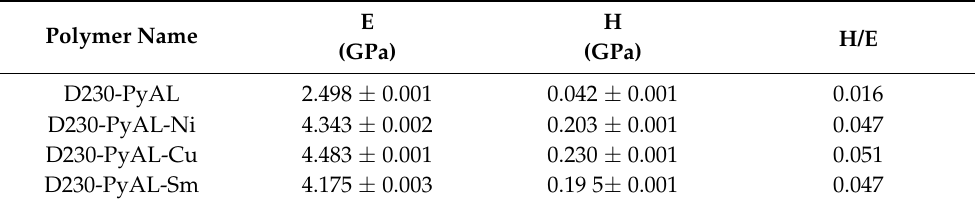
Figure 7. Young’s modulus (E) and hardness (H) are calculated from the nanoindentation. Table 5. The results obtained from the nanoindentation test.